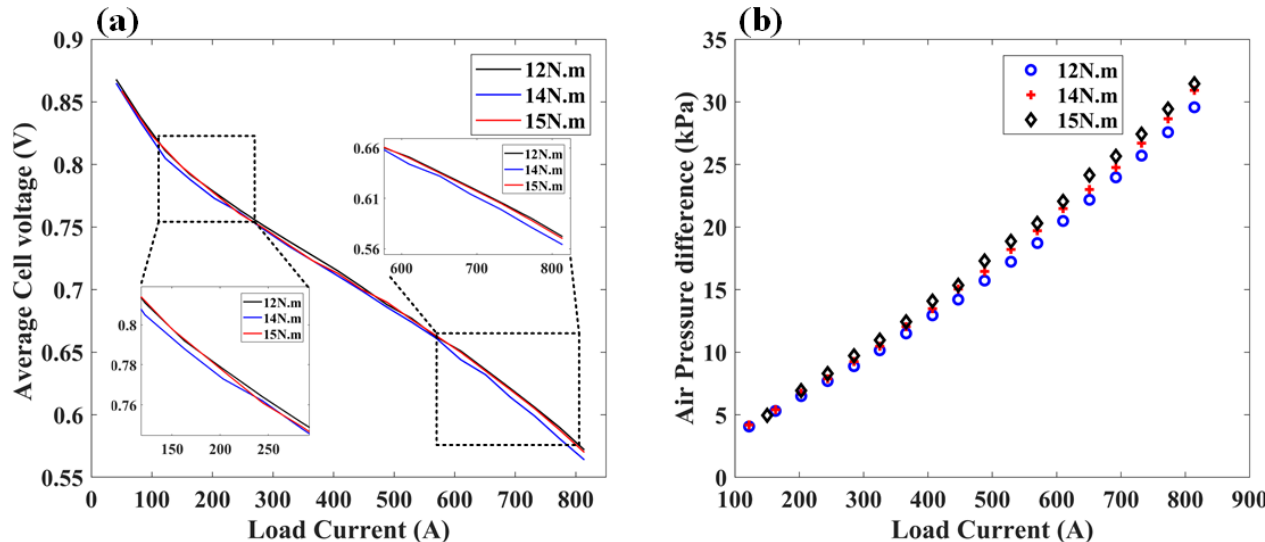
Figure 3. ( a ) Curve of the relation between the load current and average cell voltage; ( b ) the current- and air-pressure-difference curve.